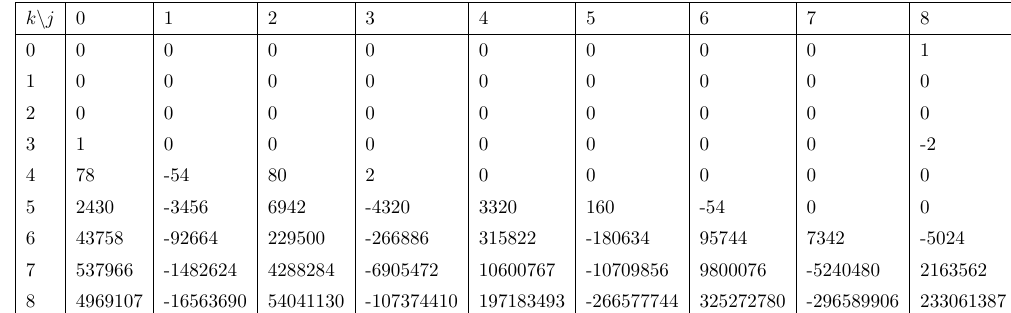
Table 84. Table of b jk coe(cid:14)cients for h E 6